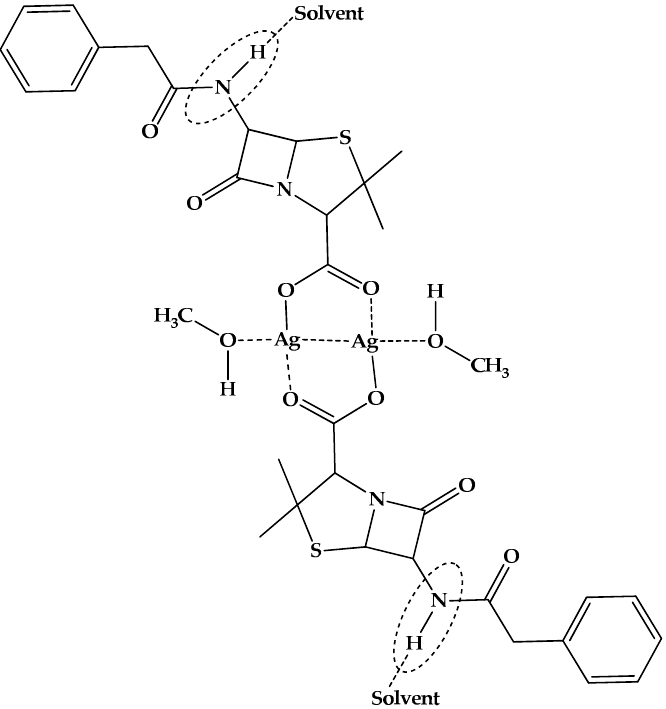
Figure 7. Structure of PenAg refined by the analytical and spectroscopic data.